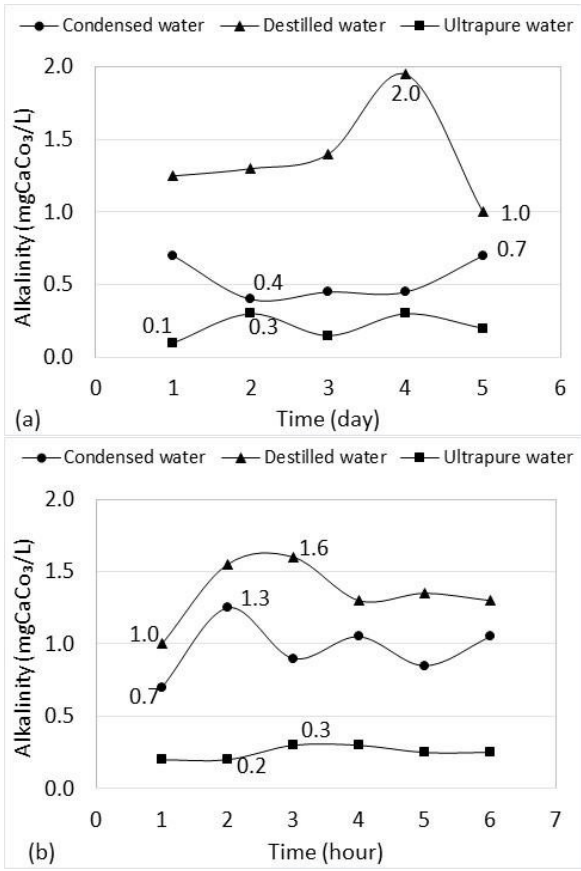
Figure 6: Alkalinity values found in condensed, distilled and ultra- pure water, with daily (a) and hourly (b)